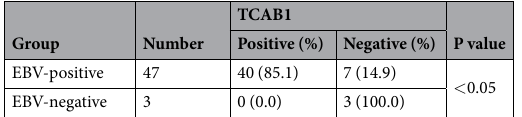
Table 1. Examination of EBV and TCAB1 in NPC clinical